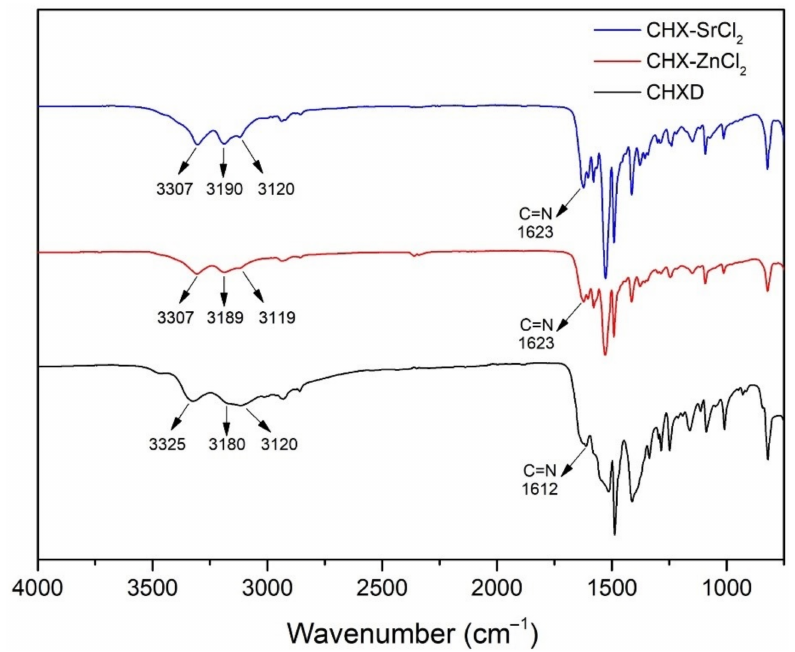
Figure 3. FTIR results of CHX-SrCl 2 , CHX-ZnCl 2 , and CHXD particles. The XRD plots of the CHX-SrCl 2 and CHX-ZnCl 2 particles indicated they had missing peaks at the 6.20, 11.40, 14.47, 16.18, 16.61, 19.09, and 36.27 degree 2 theta positions, which were present in the CHXD XRD plot. There were also slight deviations in the 2 theta positions, changes in intensity for similar peaks for the CHXD and the novel particles, and signs of peak broadening (Figure 4). Crystal lattice strain and crystal size can affect XRD peak broadening, the intensity of the peaks and shifts in 2 theta positions [52]. XRD peak broadening has been previously associated with smaller crystallite size and changes to the lattice parameters, due to zinc incorporation into hydroxyapatite structure [53]. The CHX-SrCl 2 and CHX-ZnCl 2 particles also displayed new peak positions (not in the CHXD plot) at 15.81, 15.85, 18.55, 20.02, 20.83, 21.56, 28.85, 28.88, 29.85, 29.88, 31.22, 35.43, and 35.46 degrees 2 theta. The CHX-SrCl 2 and CHX-ZnCl 2 particles displayed almost the same 2 theta positions, indicating the formation of a similar particle structure after the incorporation of divalent metal ions (Sr, Zn). It is clear the new particle complexes displayed structural differences with CHXD which were confirmed by differences in polymorph structure and crystallite size (Figure